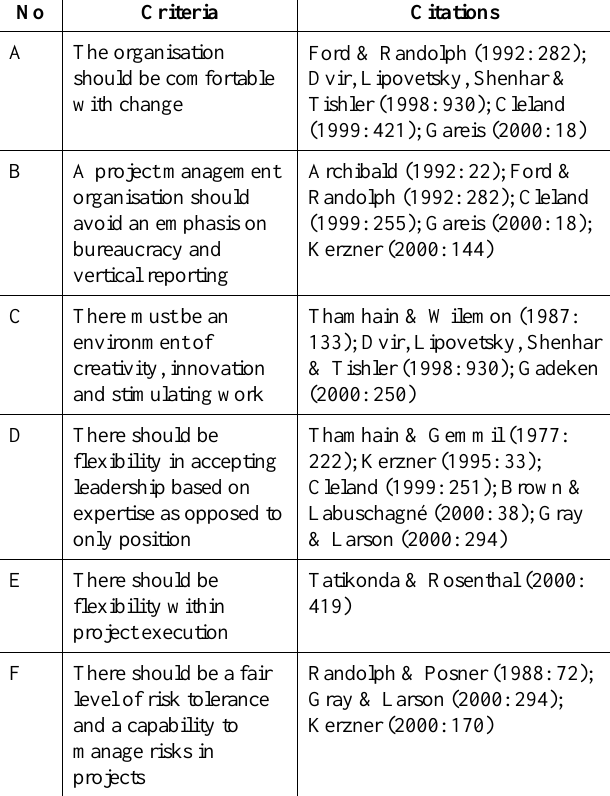
Table 2: The need for flexibility and innovativeness No Criteria Citations